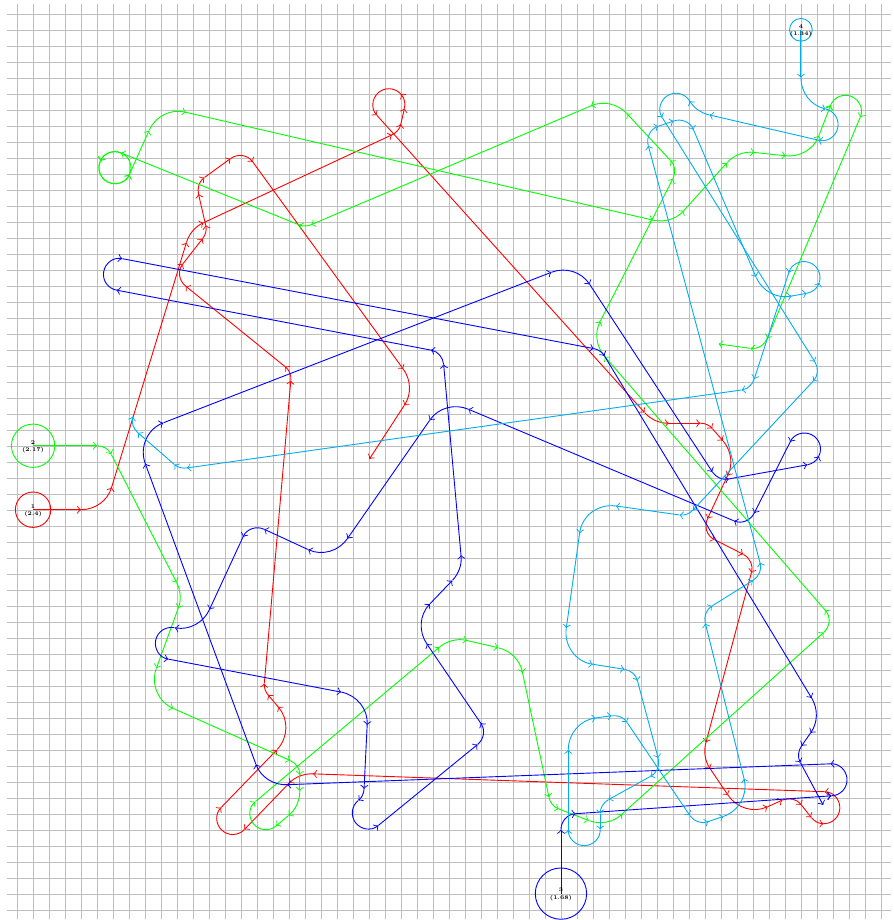
Figure 5. Visualization of benchmark instance 21 ( n = 4) with 236 sectors and 419